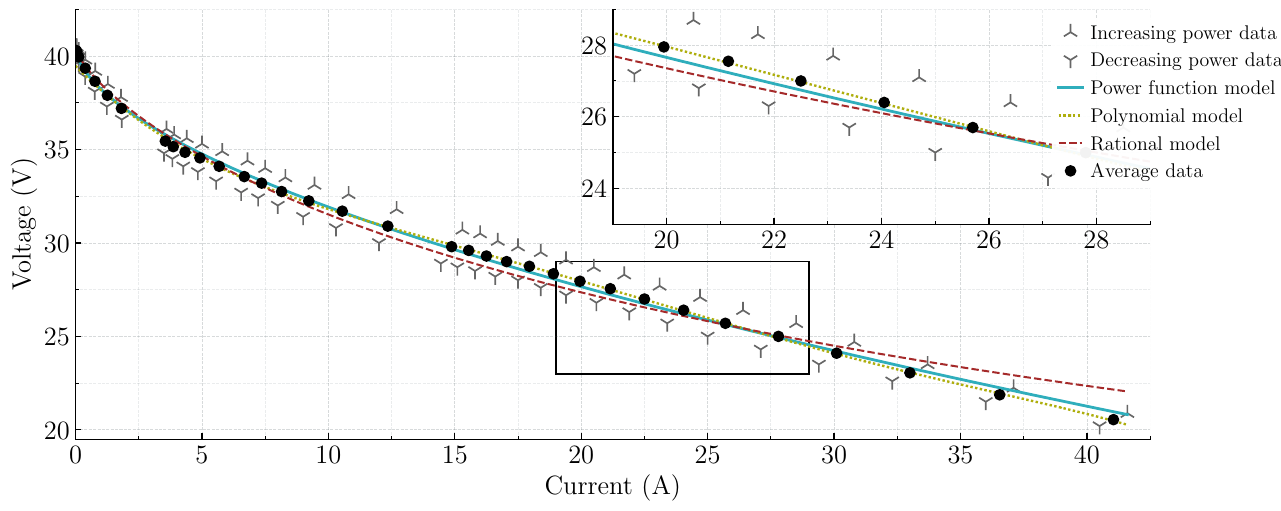
Figure 3. Models and experimental data comparison to represent the polarization curve of the PEMFC EGS. Experimental data are obtained by increasing/decreasing the power